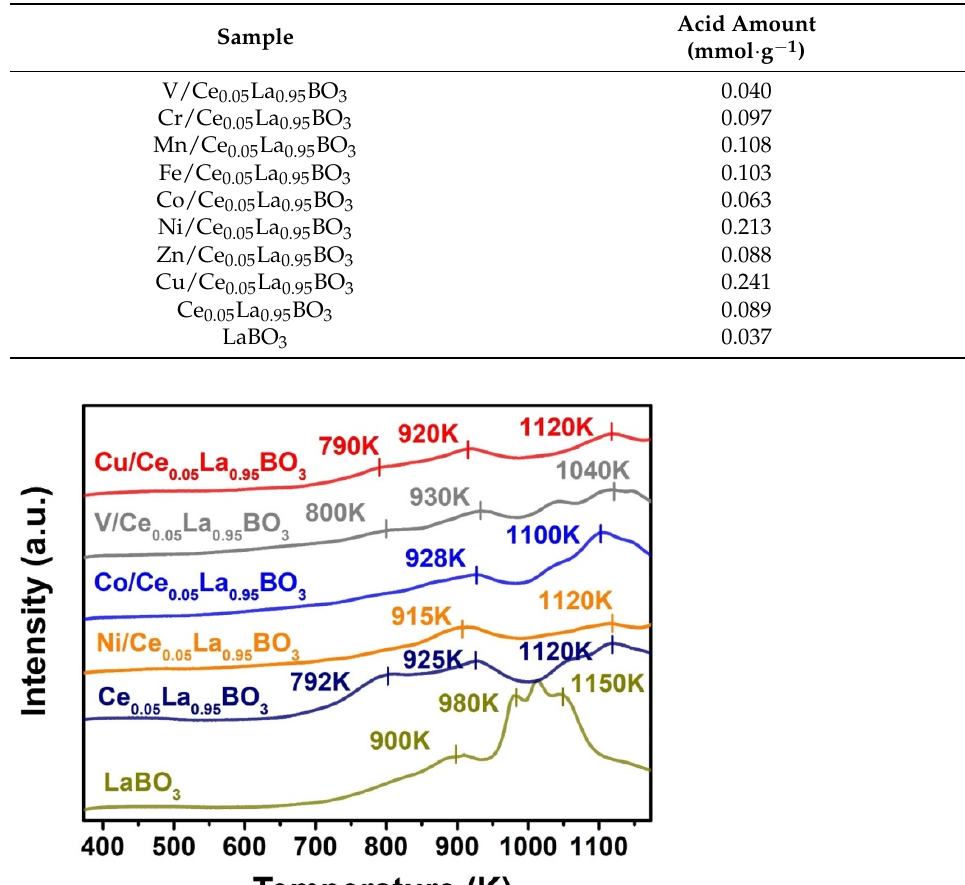
Figure 7. H 2 -TPR profiles of Cu/Ce 0.05 La 0.95 BO 3 , Ni/Ce 0.05 La 0.95 BO 3 , Co/Ce 0.05 La 0.95 BO 3 , and V/Ce 0.05 La 0.95 BO 3 .